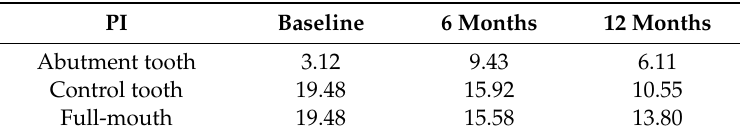
Table 4. PI at baseline, 6 months, and 12 months